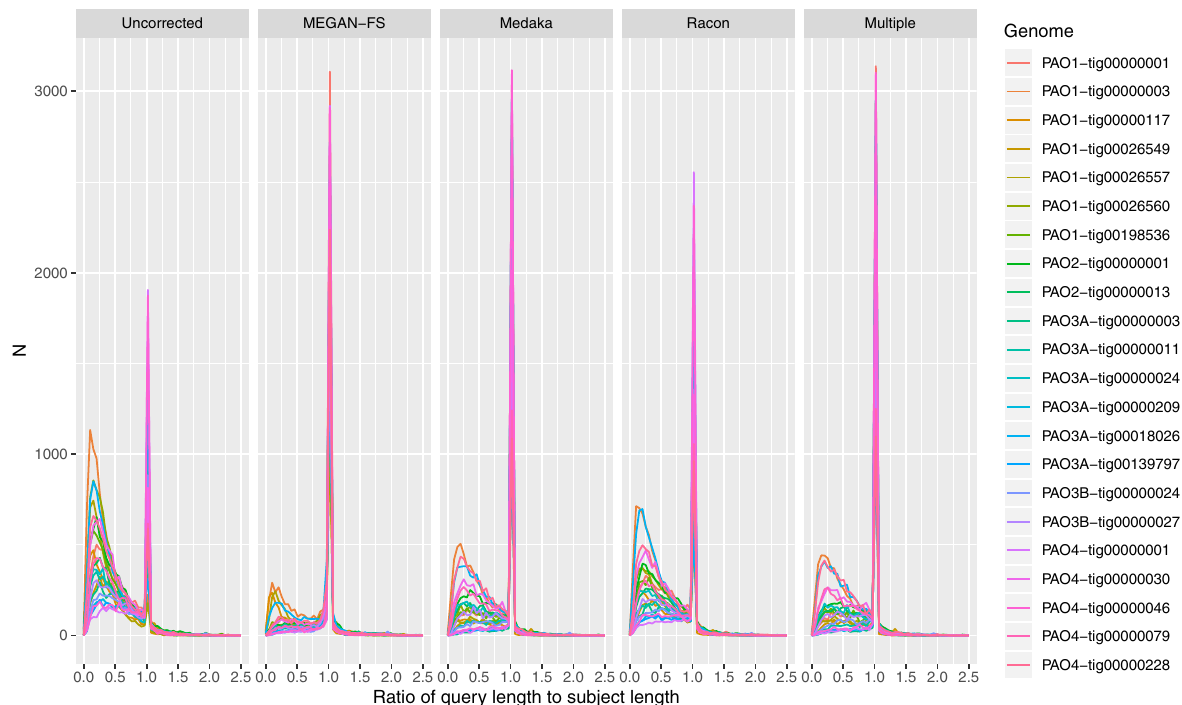
Fig. 2 Density estimates for the length ratio statistics, computed from the length of predicted genes in long read assemblies (query) and length of their best hit counterparts in cognate short assemblies (subjects), and categorised by type of sequence correction employed (from left to right, raw assembled sequence [uncorrected], frame-shift correction using MEGAN-LR, sequence correction using Medaka, sequence correction using Racon and application of the multiple procedure approach. Results from individual recovered genomes are highlighted by colour, and x -axis truncated at 2.5 units. A version with a log-scale on the vertical axis is provided in Supplementary Fig.